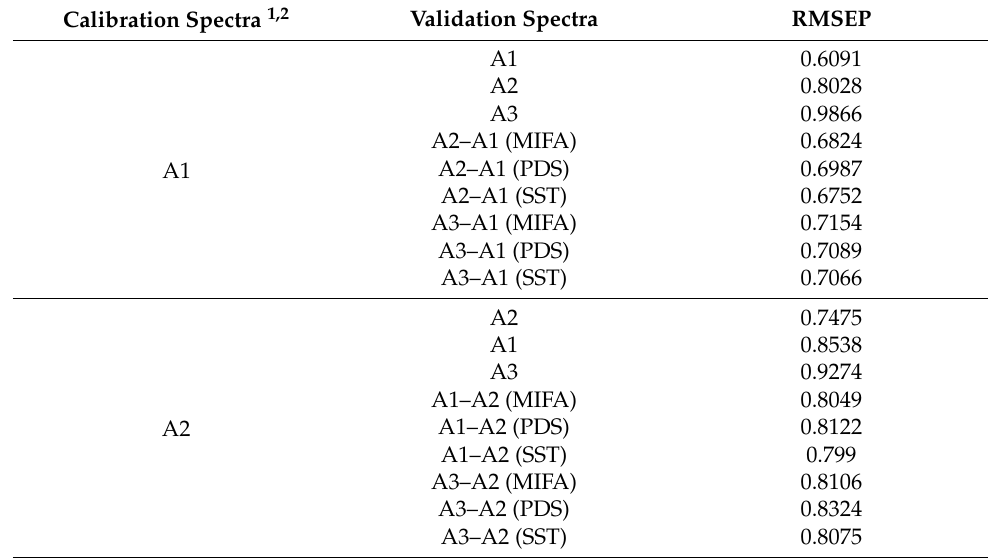
Table 2. Comparison of the results obtained by PDS, SST and MIFA for dataset